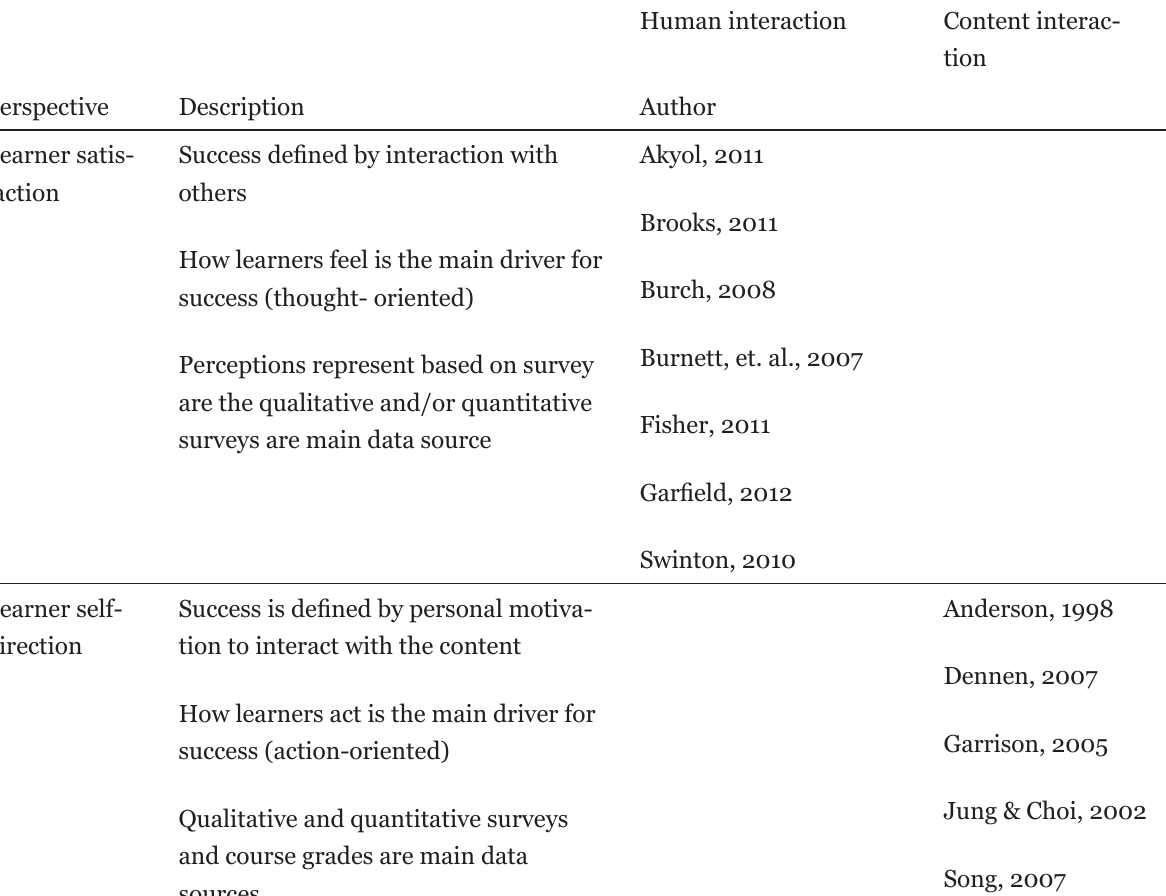
Interaction and Learning Outcomes